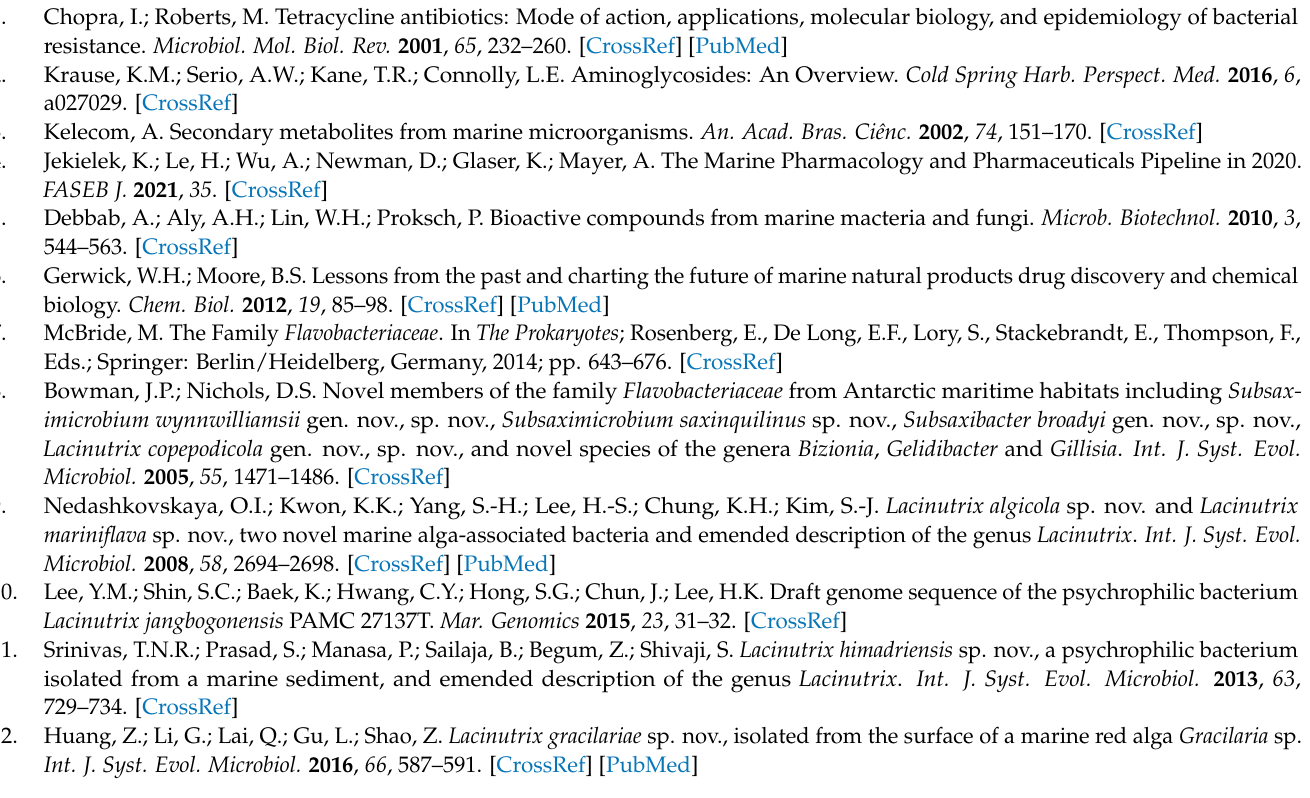
spectrum of 2 . Figure S14: Antibacterial activity of 1 and 2 against Gram-positive bacteria. Figure S15: Antibacterial activity of 1 and 2 against Gram-negative bacteria. Figure S16: Cytotoxic activity of 1 and 2 against non-malignant lung fibroblast cell line MRC-5. Table S1: 16S rRNA sequences used in the phylogenetic analysis of Lacinutrix